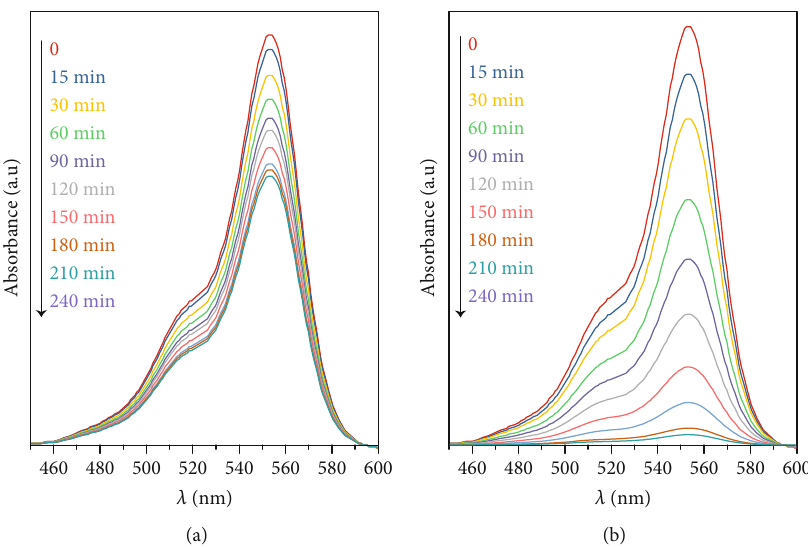
Figure 2: Absorbed light spectra for RhB at di ff erent reaction times a ff ected by (a) DS and (b) DS/GO